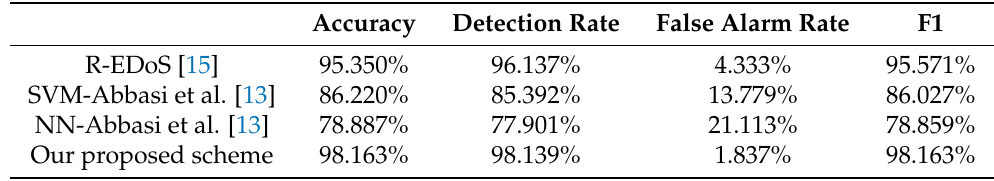
Table 8. Abnormal flow detection comparison on average between our proposed approach and other solutions in